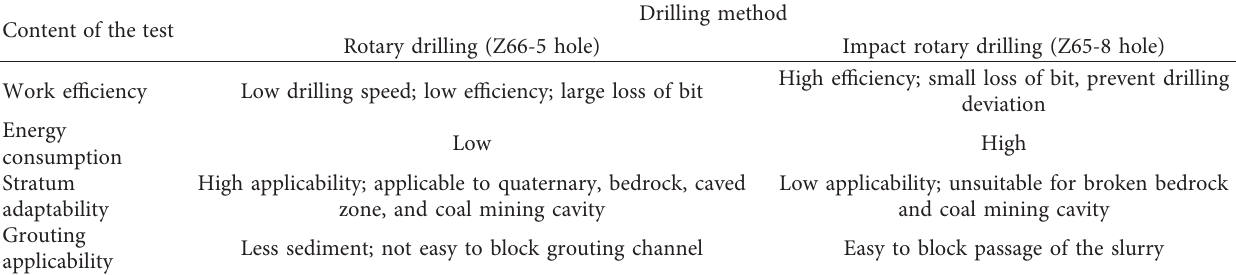
Table 3: Comparison of two drilling methods.